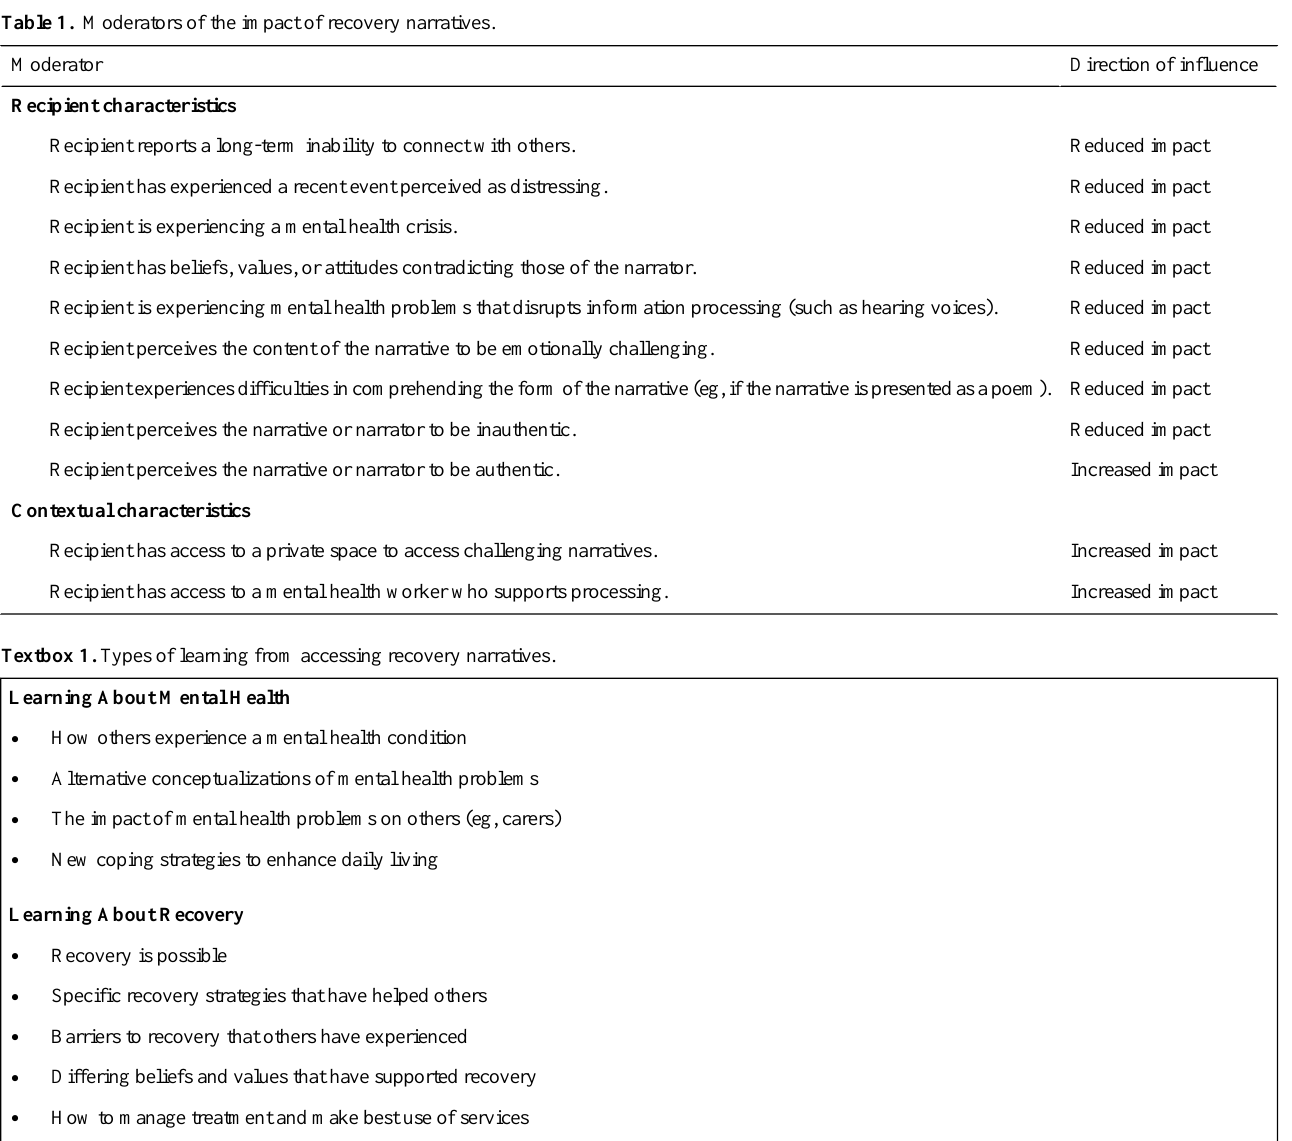
Table 1. Moderators of the impact of recovery narratives. Recipient